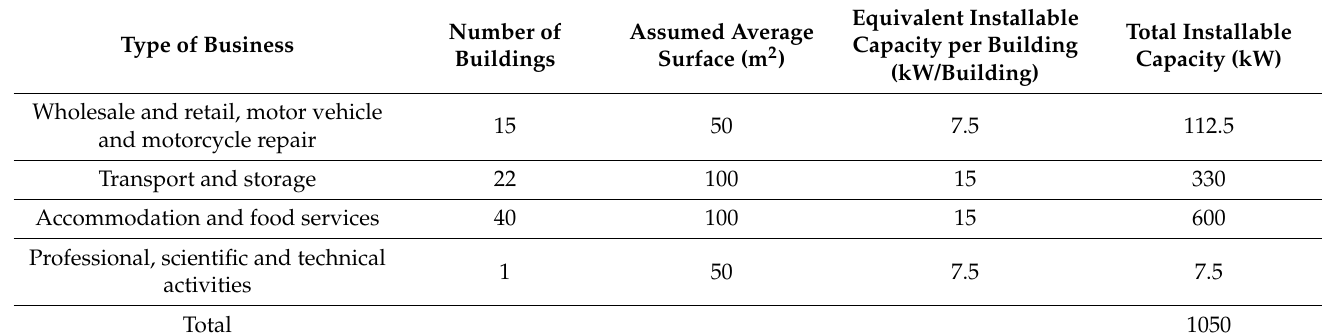
Table 2. Summary of the values used for the estimation of the total installable PV capacity in the tertiary